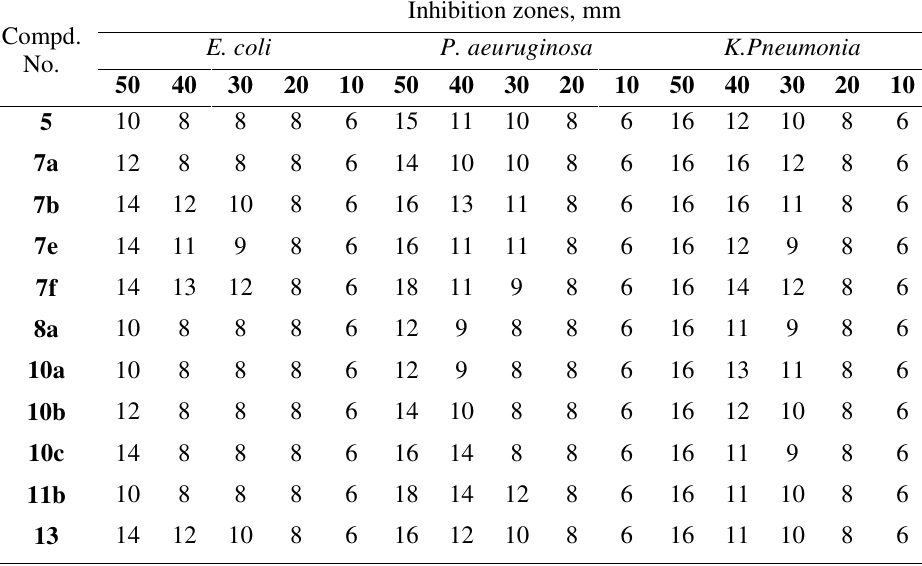
Table 3. MIC of the biological active compounds towards Gram –negative bacteria